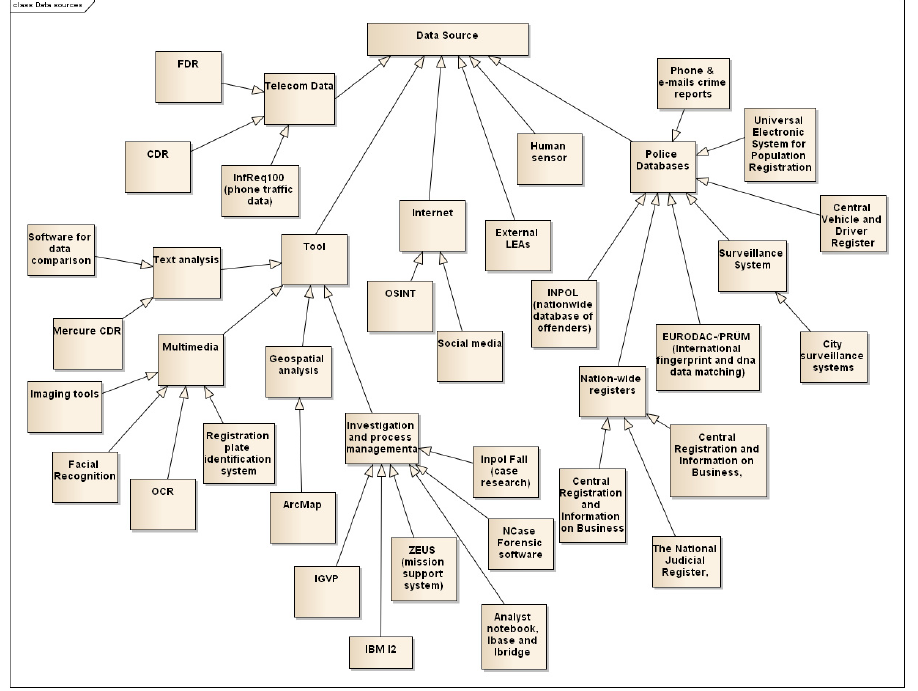
Fig. 5. Data sources identi¯ed for MAGNETO project use cases (arrows indicate \generalization"